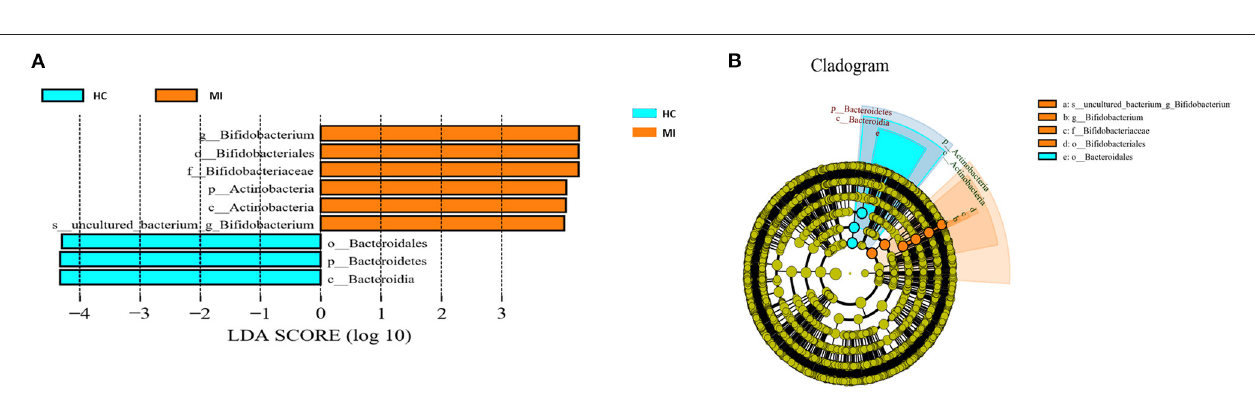
FIGURE 5 | (A) LEfSe analysis plot of differentially abundant blood microbial taxa between MI and control. (B) The taxonomic tree of differentially abundant taxa is represented by the